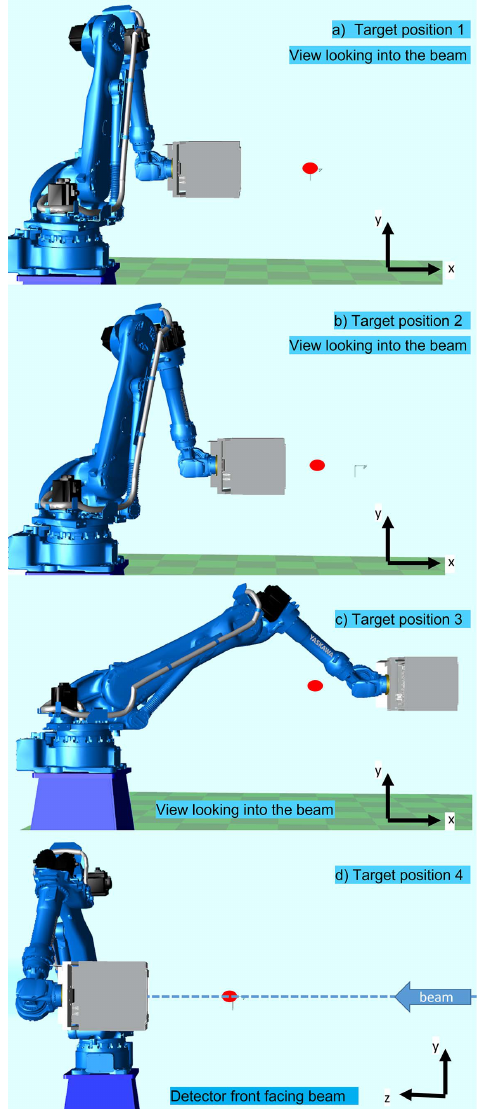
Figure 3 Schematic robot target positioning: positions 1 ( a ) and 2 ( b ) are actual measurement positions, position 3 ( c ) represents the worst case with all robot joints stretches as much as possible, position 4 ( d ) is the positioning for diffraction in the incident X-ray